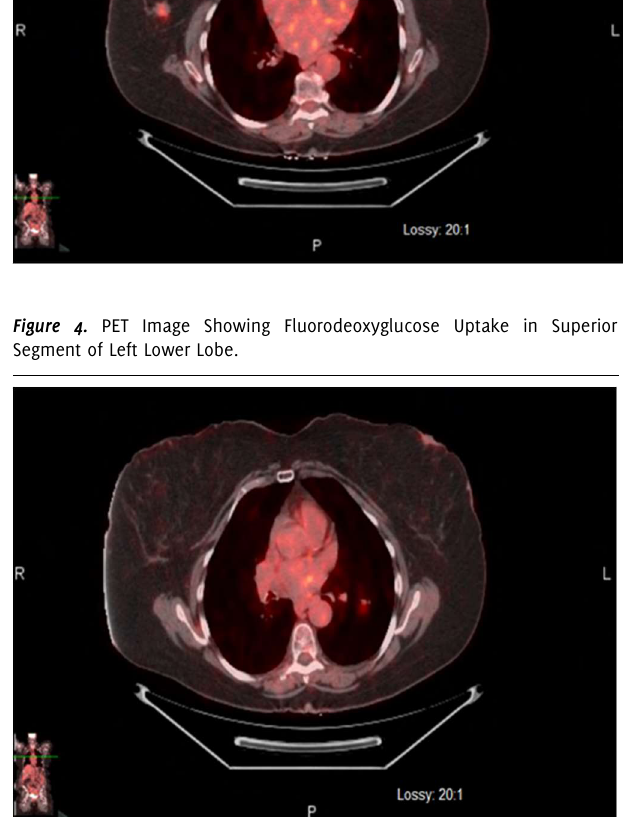
Breast-specific gamma imaging (BSGI) and Positron emission tomography-computed tomography (PET-CT) were ordered one week later. The BSGI showed a 2cm diameter area of intense focal uptake in the right breast at 9 o’clock, 15cm from the nipple with no evidence